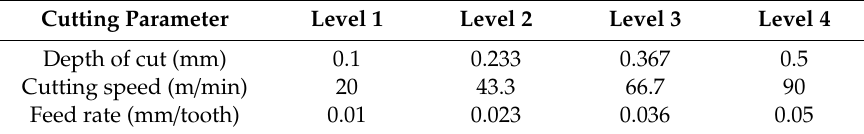
Table 2. Experimental factors and their levels.